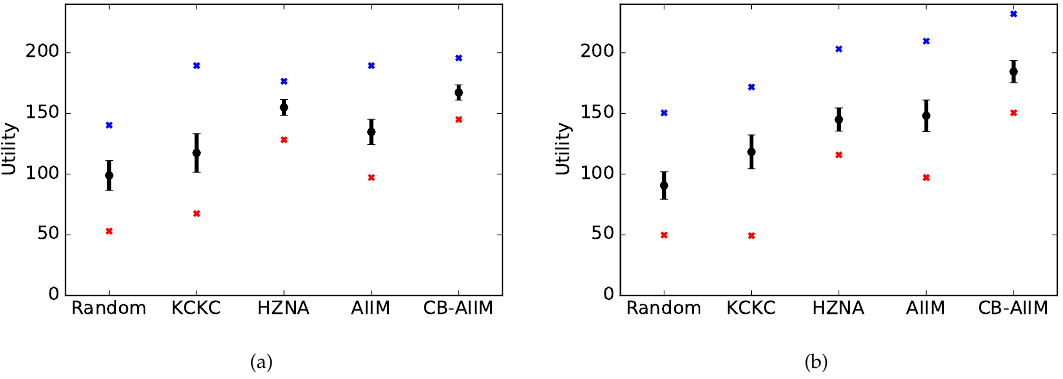
Figure 7. ( a , b ) Results for two different settings with medium classroom occupancy (24 classrooms under